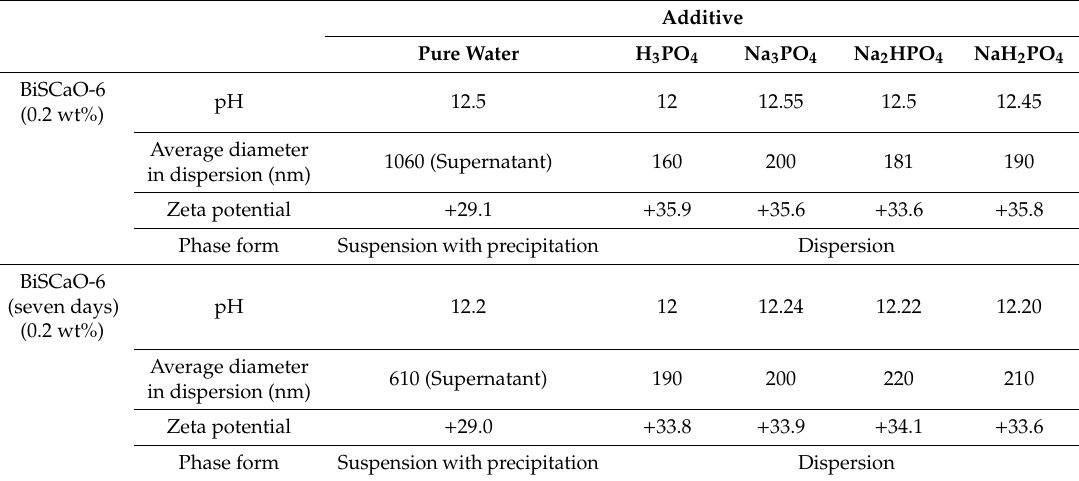
Table 3. Average diameter and zeta-potential of BiSCaO-6 particles in BiSCaO